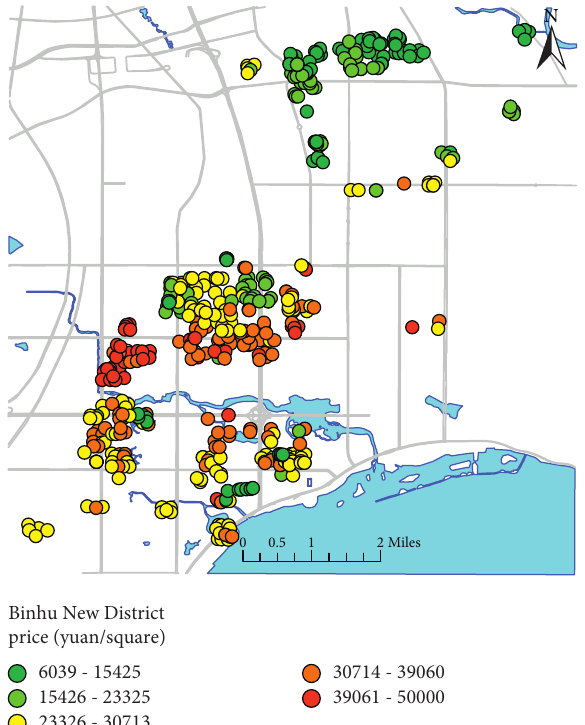
Figure 1: Spatial distribution of unit price of second-hand housing in Binhu New District.